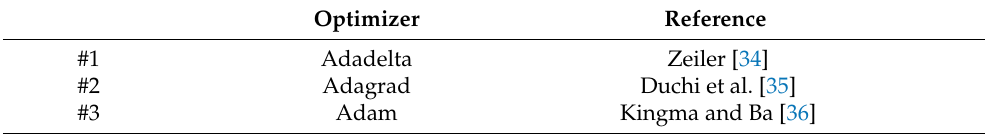
Table 3. Adaptive optimizers used in